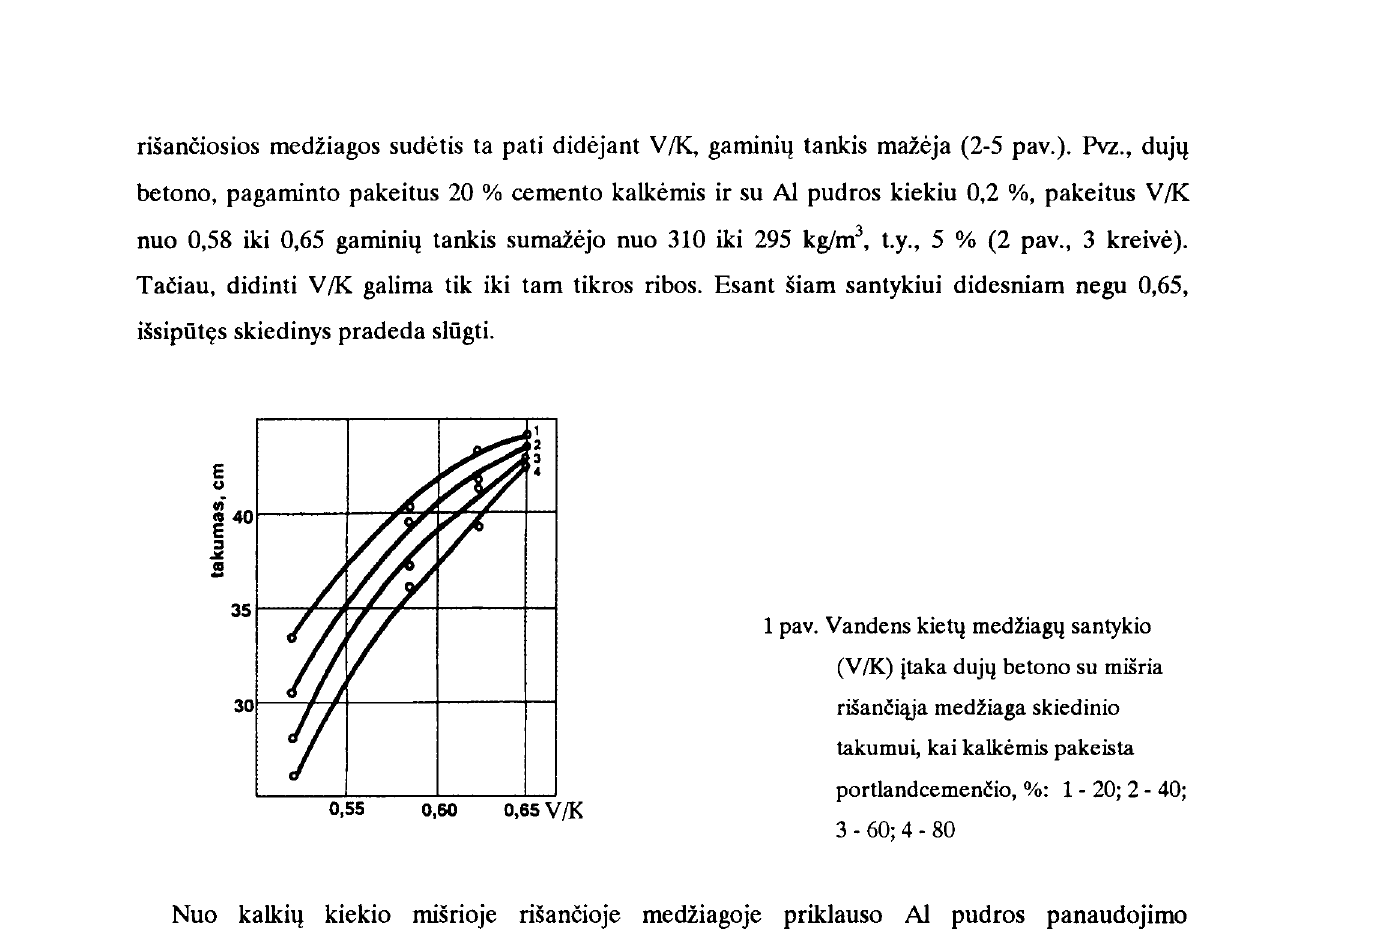
jtaka garnini4 tankio malejimui maliau reiksrninga (kreives arteja viena prie kitos). Norint elirninuoti neigiamll kalki4 jtakll duj4 betono tankio ma:linimui, reikia didinti AI pudros kiekj arba keisti vandens ir saus4 med:liag4